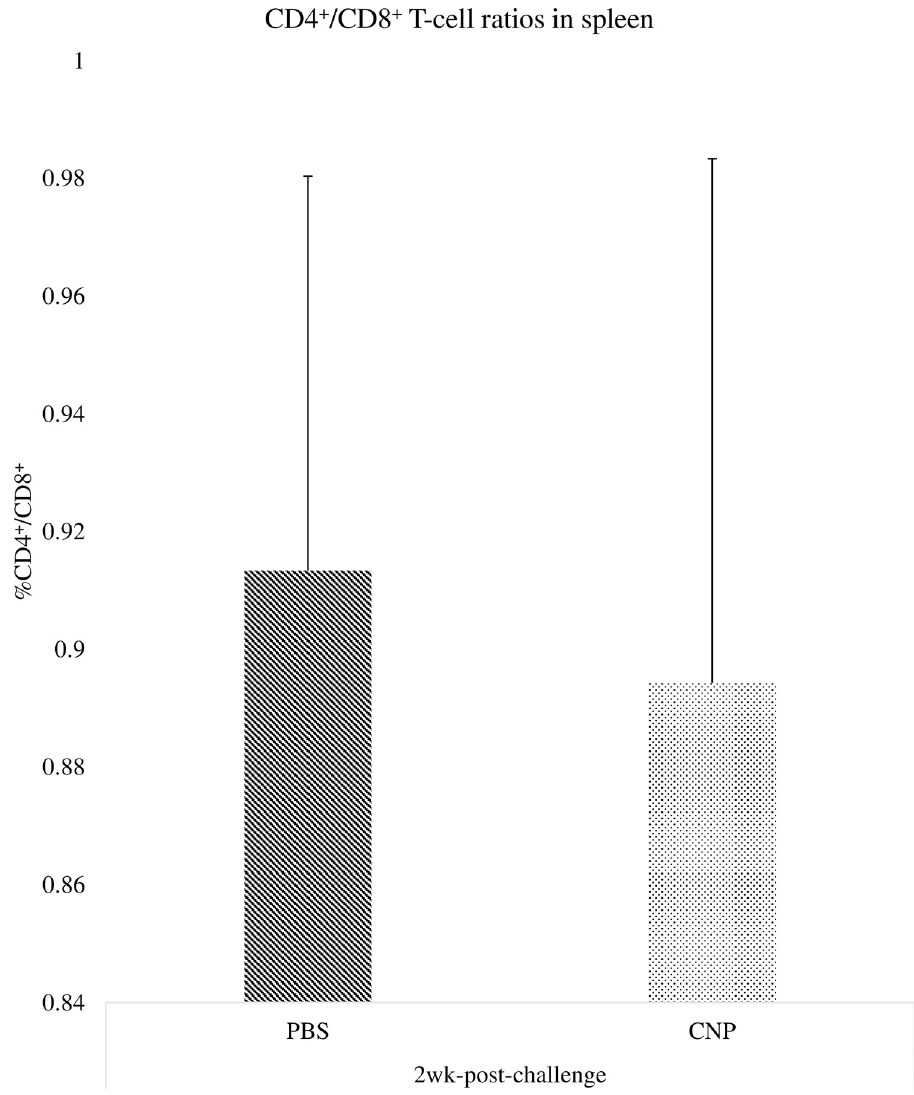
Fig 3. CD4 + /CD8 + cell ratios in cecal tonsils of chickens vaccinated with in-ovo CNP at 2wk-post-challenge. At embryonic d18, broiler eggs were vaccinated with either PBS (control) or 1000 μ g CNP vaccine. At d7 of age, birds were challenged with live SE (1.0 × 10 9 CFU/bird). The CD4 + /CD8 + T-cell percentage in cecal tonsils were analyzed by flow cytometry (Guava Eascyte; Millipore). The CD4 + /CD8 + cell percentage was analyzed after gating cells based on forward-scatter and side-scatter plot for lymphocytes. Data analyzed by parametric Student t-test; Means+SEM.Bars. n = 6. " � " means P < 0.05.